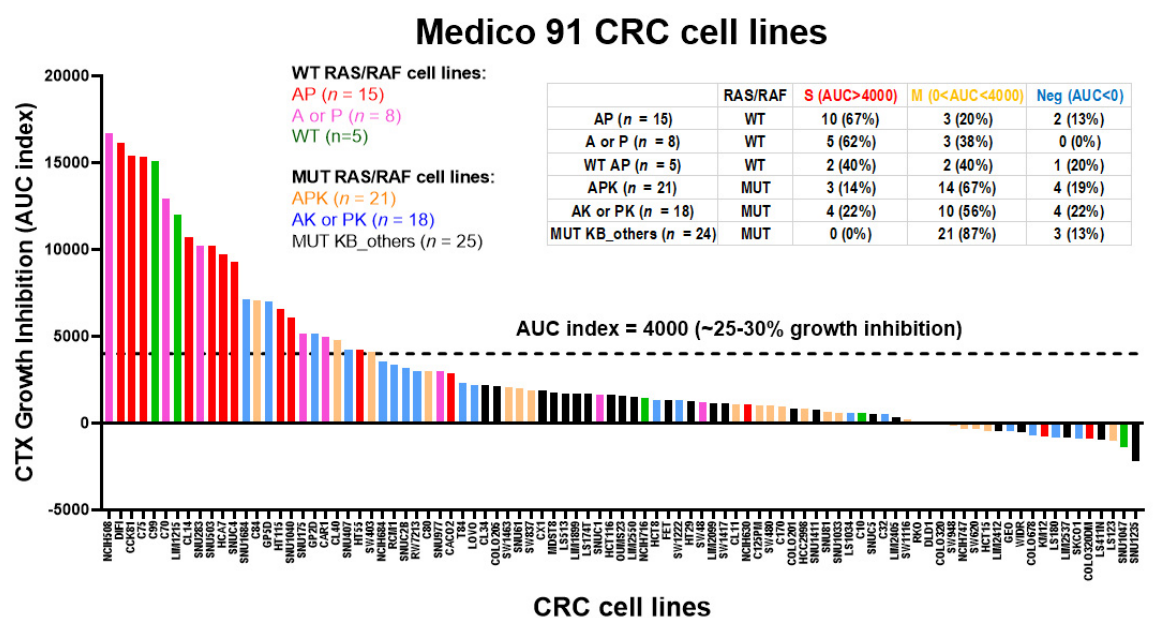
Figure 10. A diagram of in vitro growth inhibition by cetuximab (CTX) (AUC index) (from high to low) vs. 6 MUT vs. WT APC/TP53/RAS(KRAS/NRAS)/BRAF subgroups in Medico CRC cell lines. Notably, cell growth inhibition by cetuximab was measured by AUC ‐ index representing the area under the concentration–inhibition curve of cetuximab at 0, 0.001, 0.01, 0.1, 1, 10, 25, 50, and 100 μ g/mL, which measures overall dose ‐ dependent drug inhibitory effects (Medico et al., 2015, ref [30]). That is, higher AUC index, higher growth inhibition. The AUC index = 4000 line represents up to ~25–30% of growth inhibition at higher CTX concentrations. Accordingly, S (sensitive) (AUC > 4000) represents >25–30% of growth inhibition; M (modest) (0 < AUC < 4000) represents 0 to 25–30% of growth inhibition; Neg (AUC < 0) represents negative effects on growth inhibition (i.e., CTX ‐ treated cells had more growth than non ‐ treated cells).